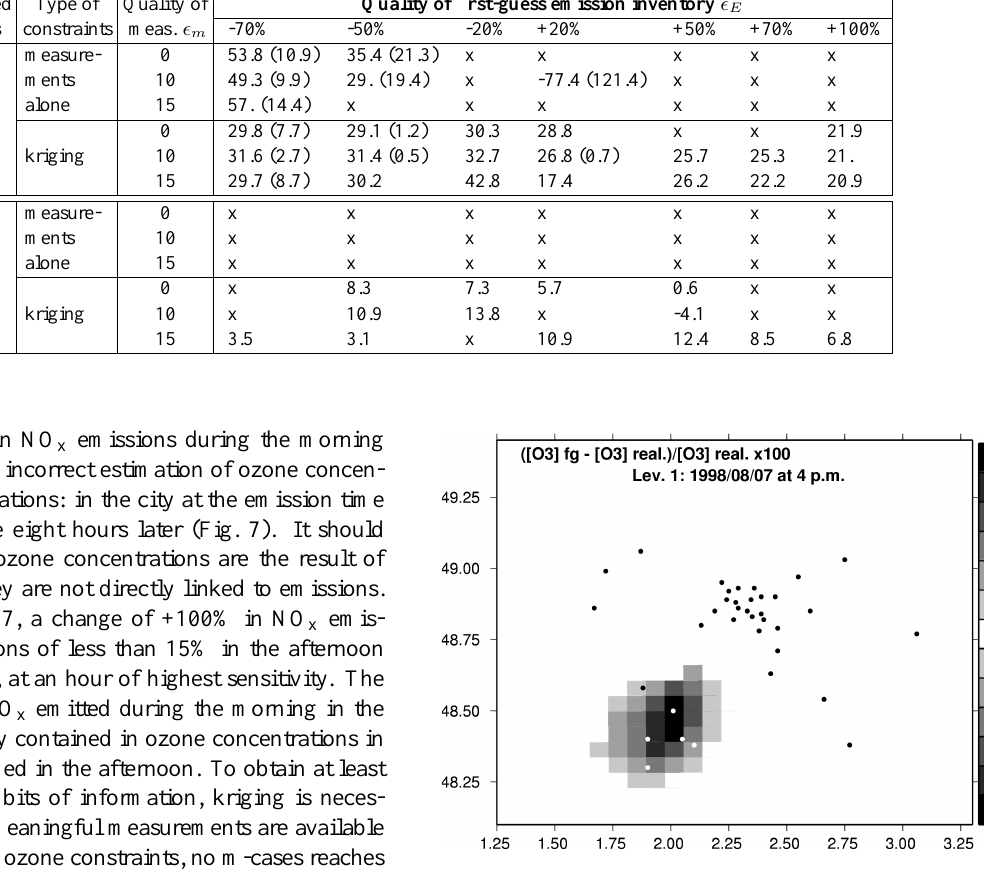
Table 1. Average scores of optimizations (in %) (and matching variances) for NO x inversion with two types of NO or ozone constraints; x=convergence not reached. Pison et al.: Inverse modeling of emissions 9 Measured Type of Quality of